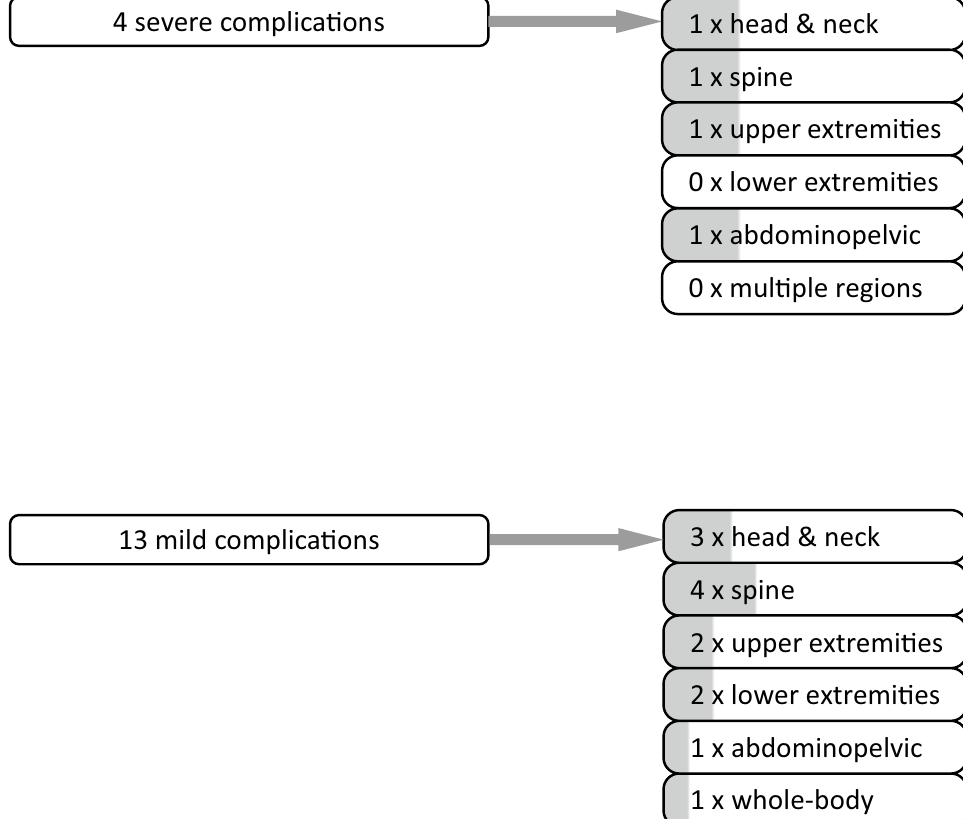
Fig. 3 Number of severe and mild MRI complications observed for 66 MRI scans of CI patients with an MR-conditional